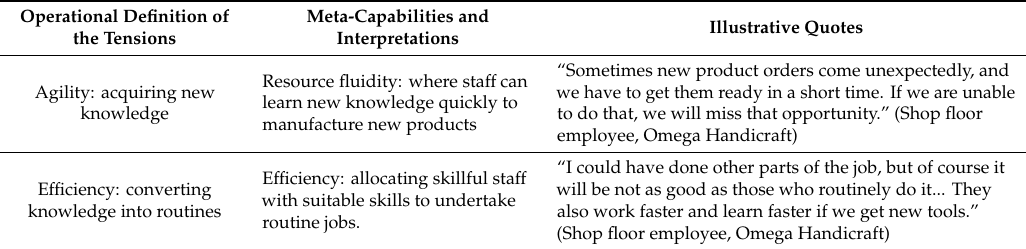
Table 5. Develop new knowledge or convert knowledge into